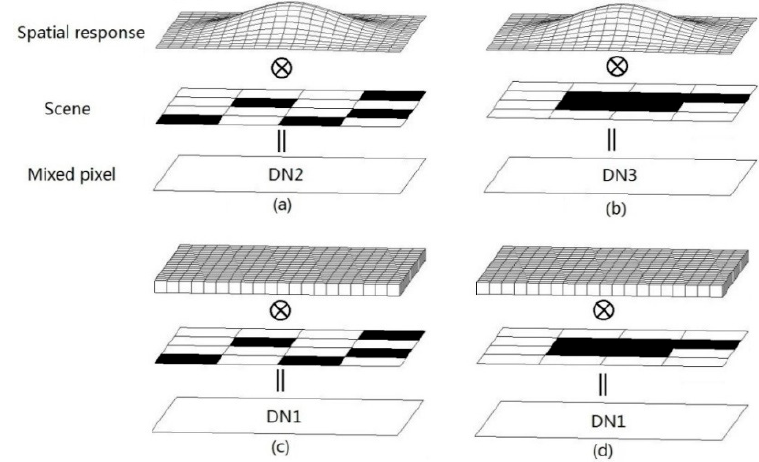
Figure 1. Schematic diagram of the impact of the nonuniform spatial response of the sensor’s detector on the DN value of a mixed pixel. ( a ) and ( b ) represent the imaging processes of surface scenes with different object distribution patterns and an identical areal proportion of 5/16 (the black and white cells indicate the target and background objects, respectively). The DN value of the mixed pixel in ( a ) (DN2) is distinguished from the one in ( b ) (DN3) by the nonuniform spatial response of the sensor’s detector with a two-dimensional normal function. The scenes in ( c ) and ( d ) are the same as those in ( a ) and ( b ), respectively, but in the case of a uniform two-dimensional rectangle function of a sensor’s spatial response, the mixed pixels generated by the convolution operation have the same DN value (DN1).